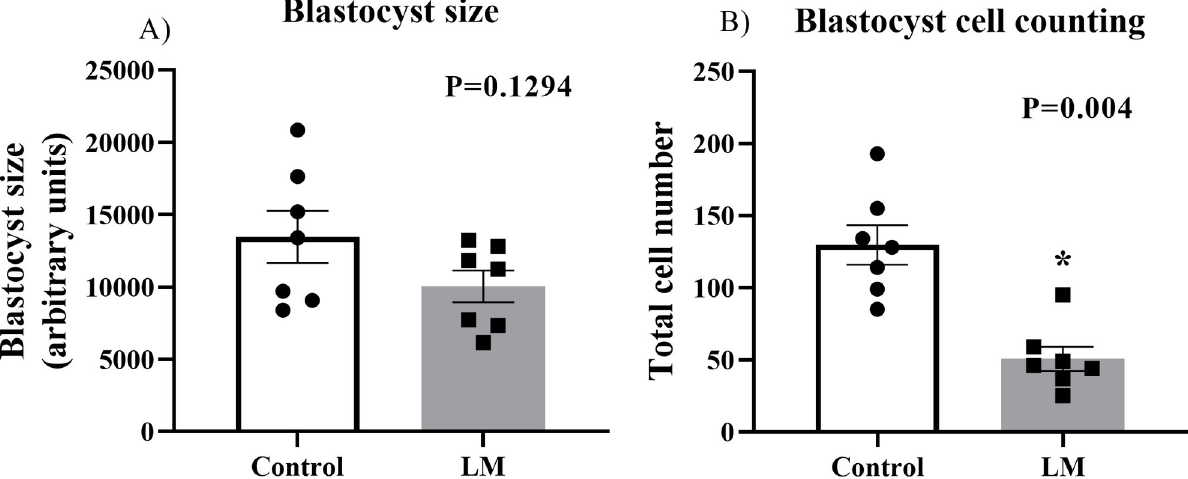
Fig 7. Blastocysts analysis. A) Blastocysts size (n = 7); and B) Total cell counting of day 7 blastocysts (n = 7) from control or LM group. Statistics performed by Student’s t test, asterisk means statistical difference (P < 0.05). Standard bars represents the